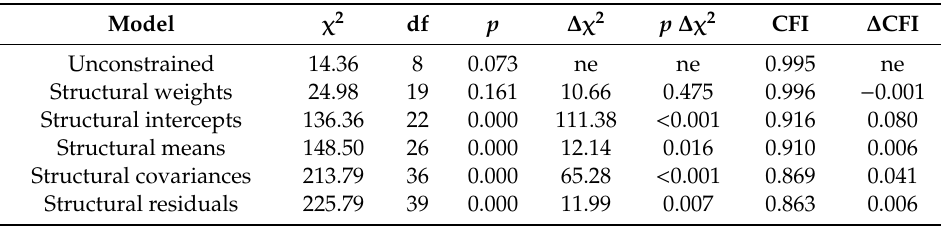
Table 4. Fit indexes for multi-group analysis of invariance across